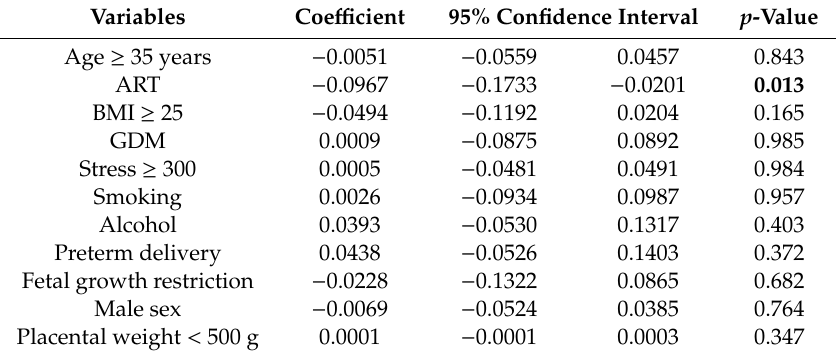
Table 3. Multivariate correlation analysis of telomere length with material perinatal